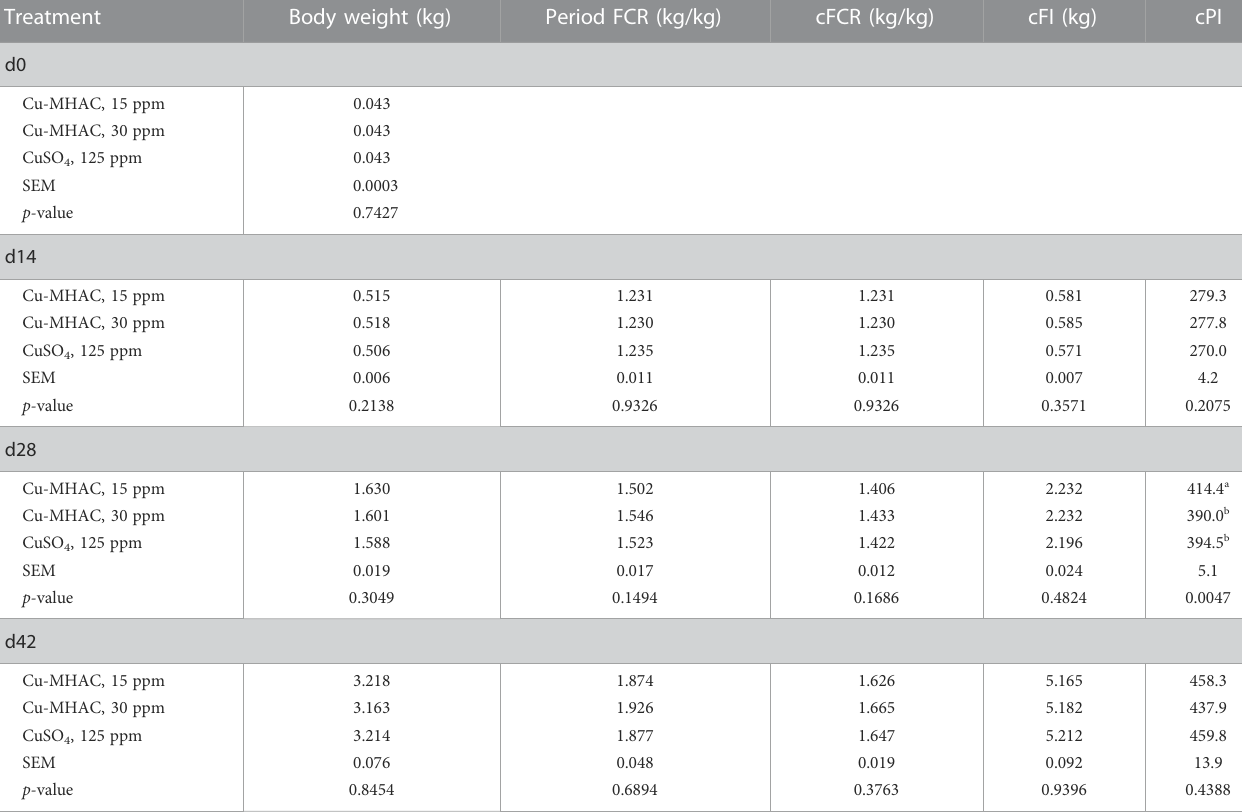
TABLE 9 Growth performance of broilers in experiment #2. Treatment